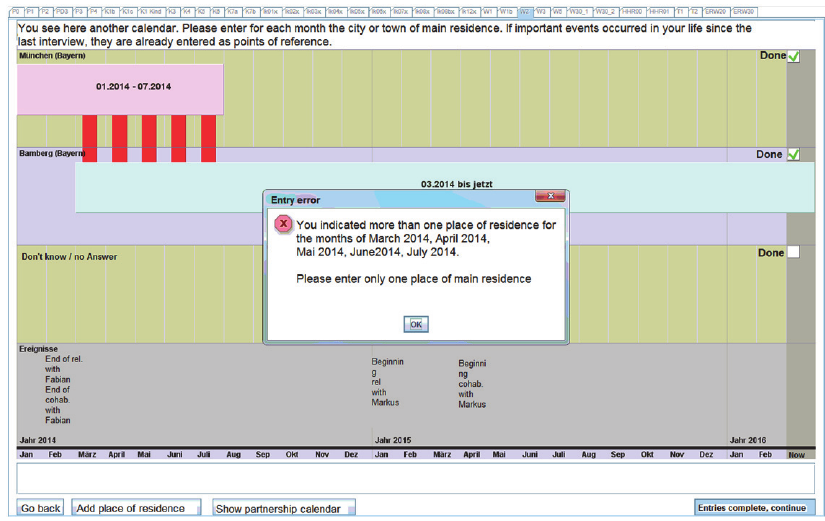
Residence calendar. The respondent entered parallel residence spells for five months instead of marking only the main place of